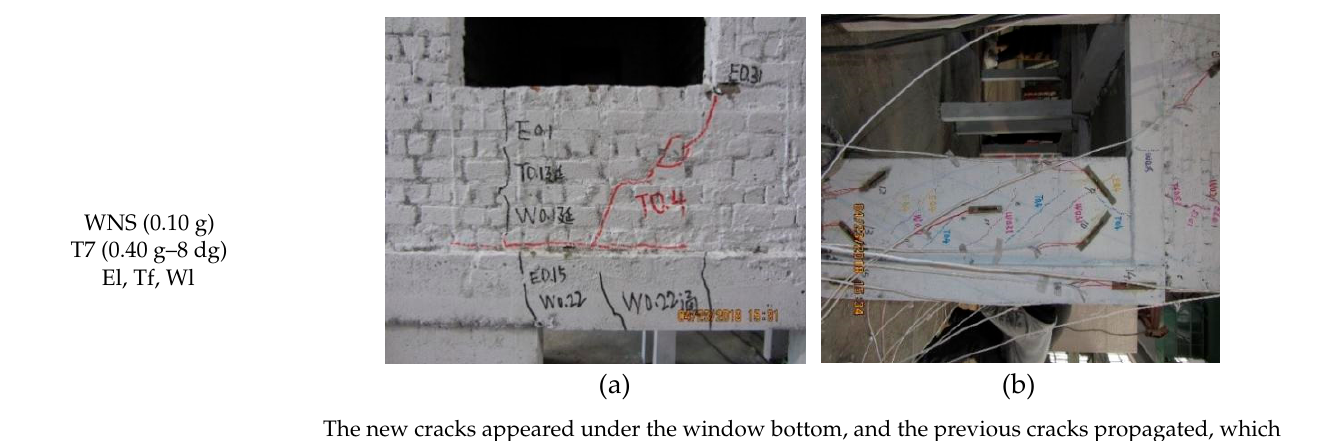
propagated, which further promoted the triangle failure area (a). The oblique